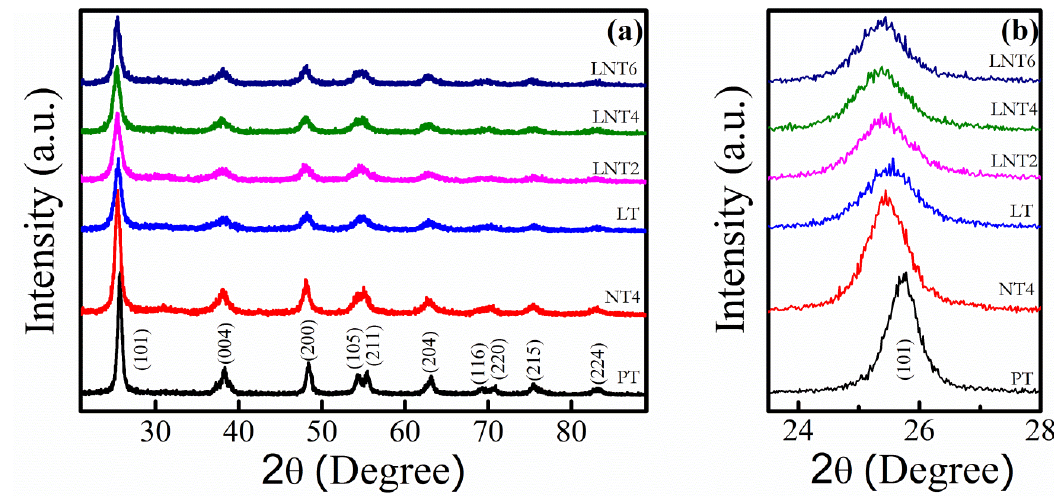
Figure 1. ( a ) XRD patterns of NPs. ( b ) Amplified image of ( a ).